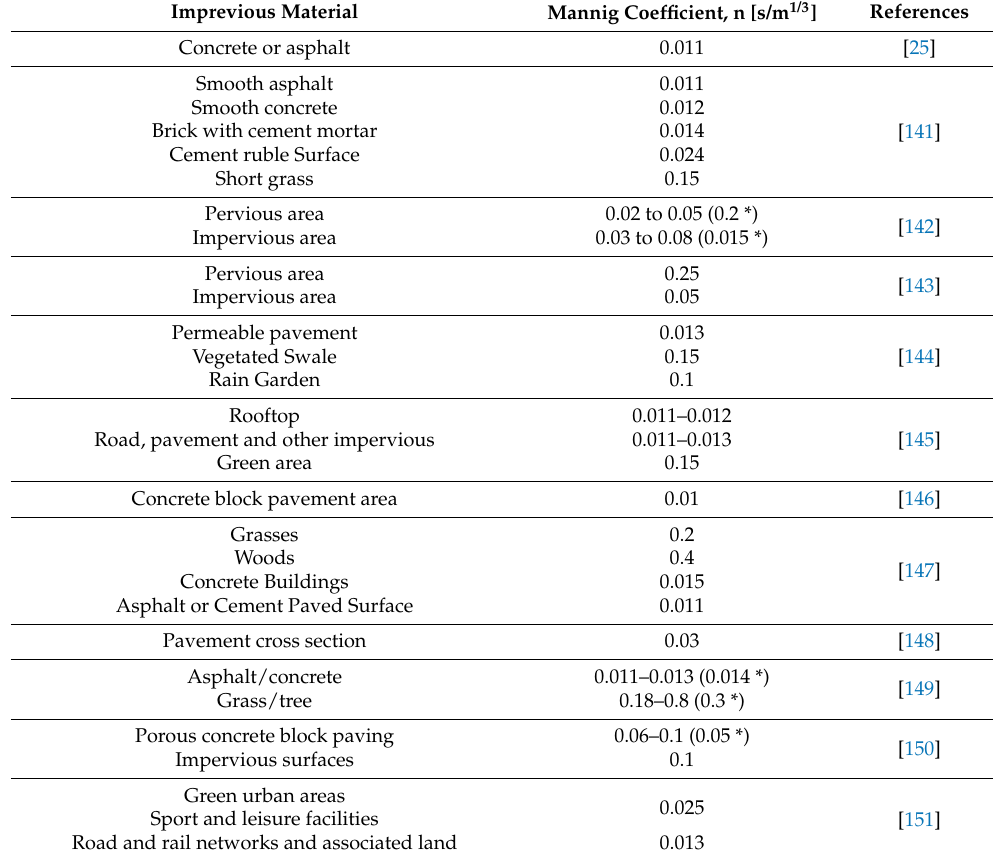
Table 4. Exemplary values of Manning’s roughness coefficient for various land type